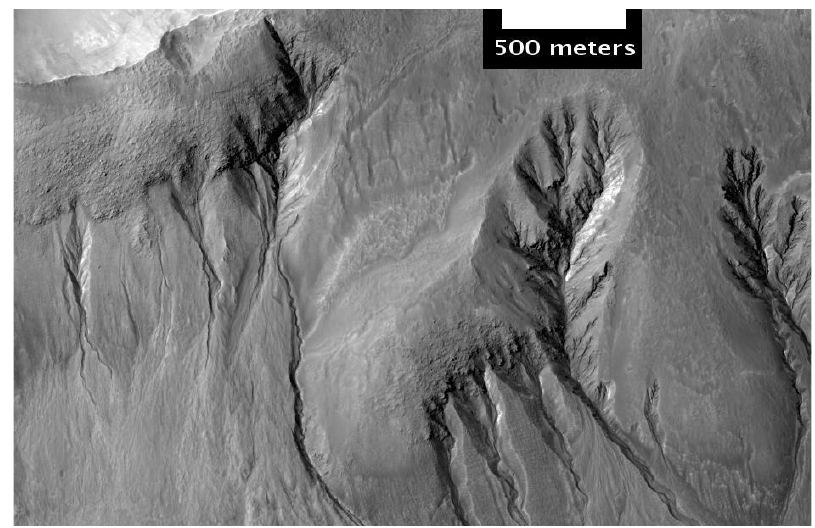
Figure 14. Branched gullies.